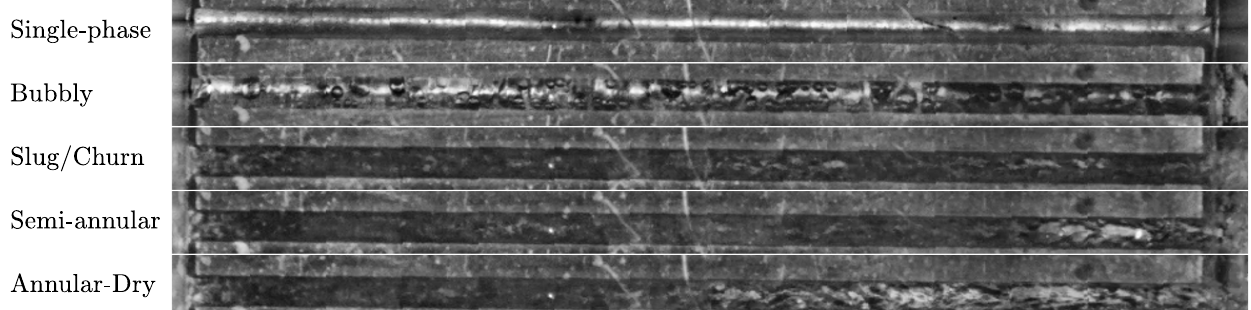
Figure 7. Images of the dominant flow patterns in the central channel of the heat sinks; labels refer to the conditions in the proximity of the outlet (right